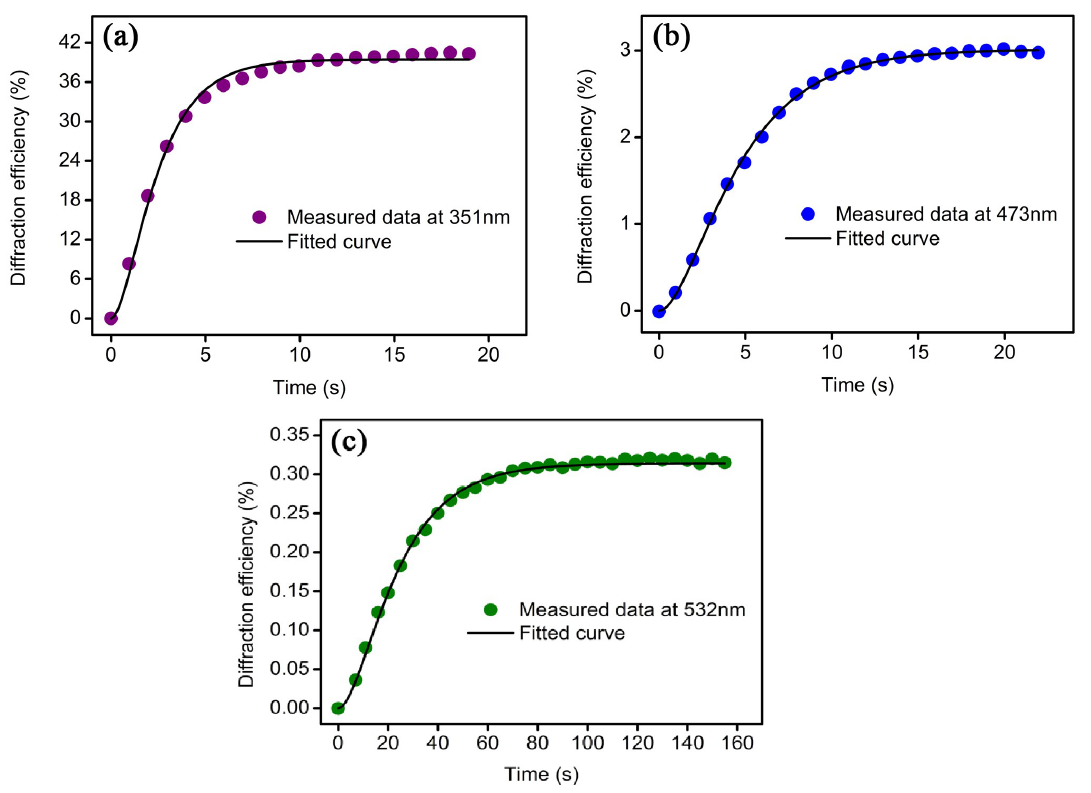
Figure 2. The measured diffraction efficiency as a function of time for CLN 100 measured at various wavelengths: ( a ) 351 nm; ( b ) 473 nm; and ( c ) 532